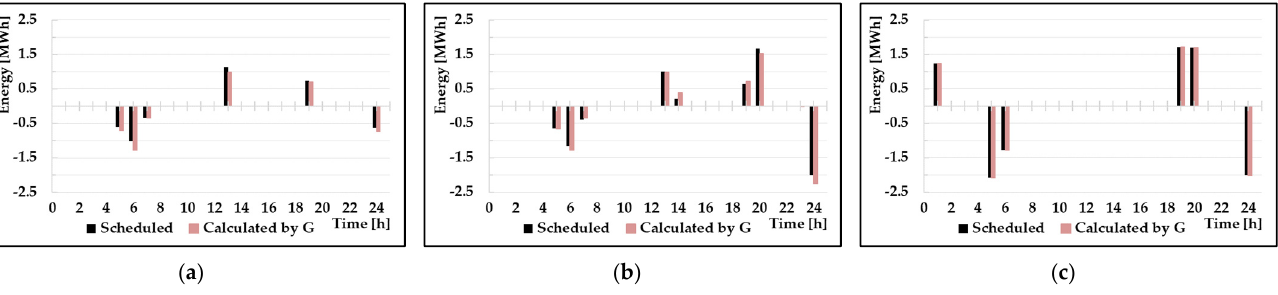
Figure 9. Charging/discharging patterns for Scenario B using methods ( a ) I 70 , ( b ) I 80 , and ( c ) II.